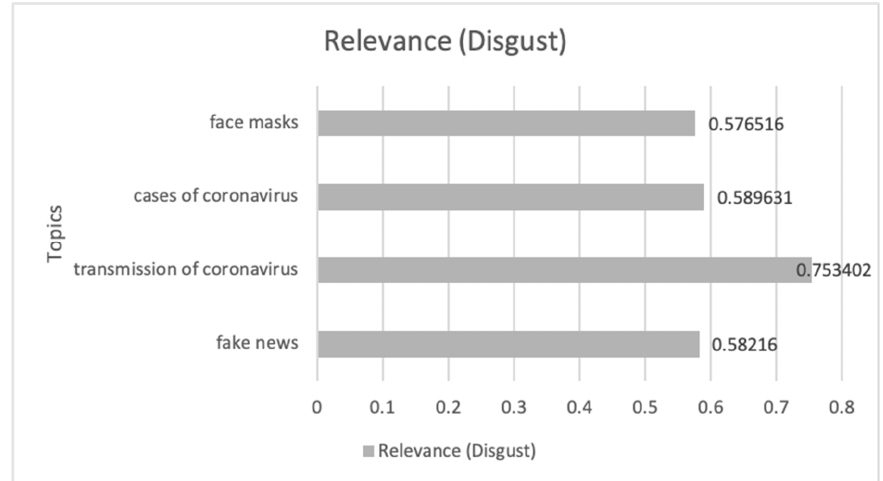
Figure 13. The themes related to COVID-19 and Sadness emotion that have impacted most along with its impact